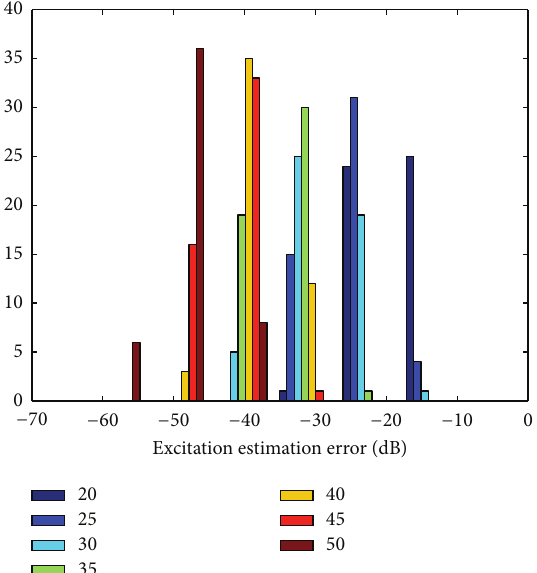
Figure 3: Histogram (simulations) of MSE of the ℓ 1 solution: 𝑆 = 2 , 𝑀 = 11 , and SNR ranging from 20dB up to 50dB.